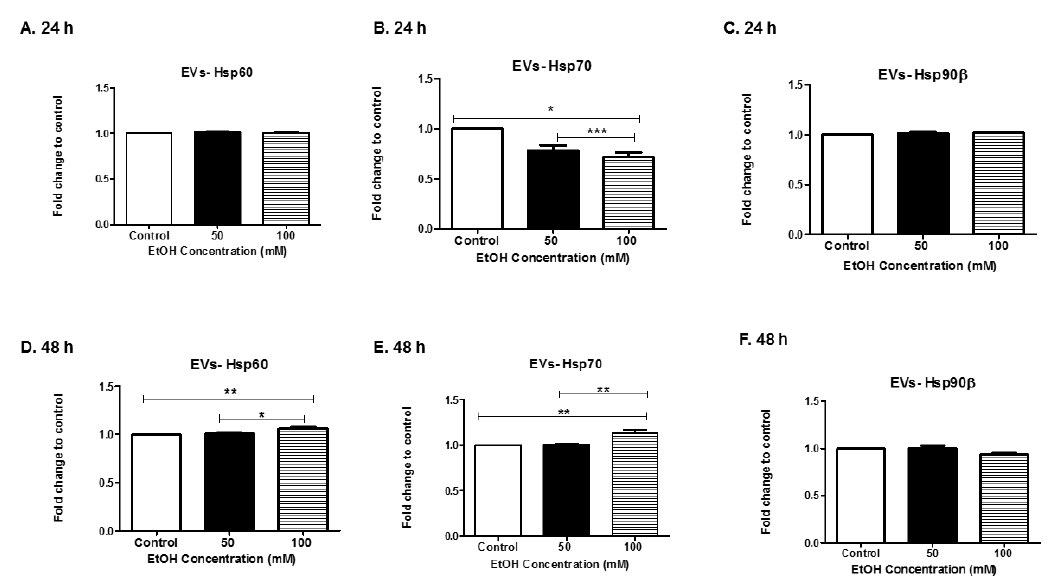
Figure 4. Production of heat shock proteins into HeLa-derived EVs. ( A , D ) Hsp60, ( B , E ) Hsp70, and ( C , F ) Hsp90 β were observed in EVs after EtOH dosing at 24 h or 48 h using ELISA. Data are presented as the means ± SEM of eight independent experiments. Significance is defined as * p ≤ 0.05, ** p ≤ 0.01, and *** p ≤ 0.001.